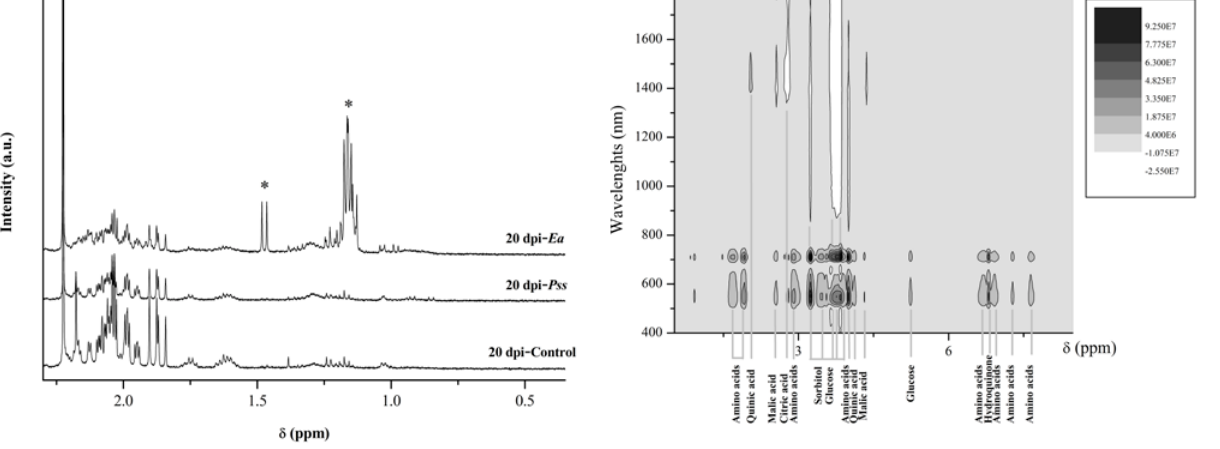
Figure 6. NMR spectra for 20 dpi- Ea , 20 dpi- Pss and 20 dpi- control pear leaf samples (signals of polysaccharide and alanine are marked with asterisks).